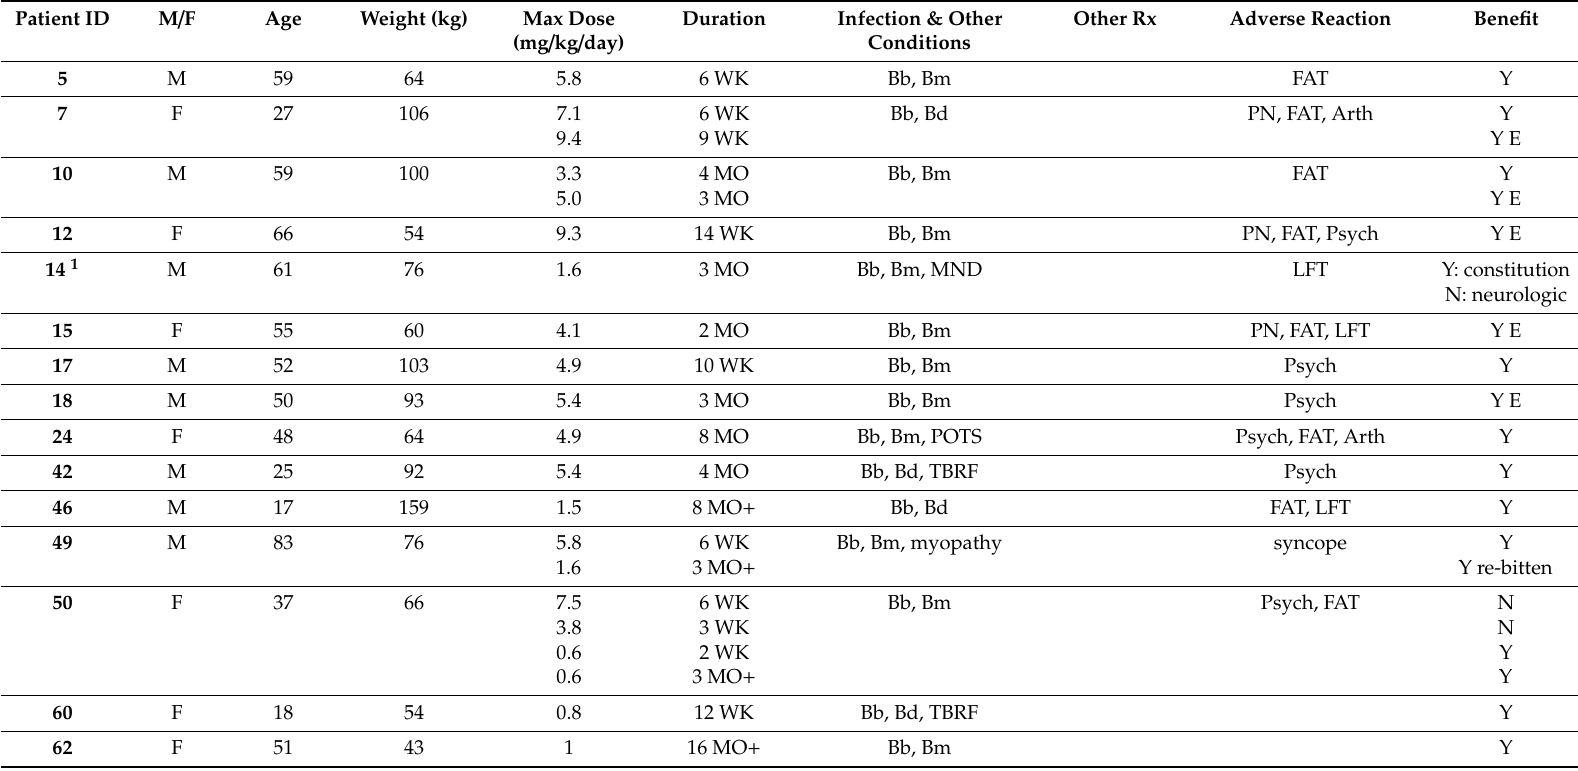
Table 4. E ff ects of disulfiram treatment on babesiosis co-infection of Lyme disease ( n =